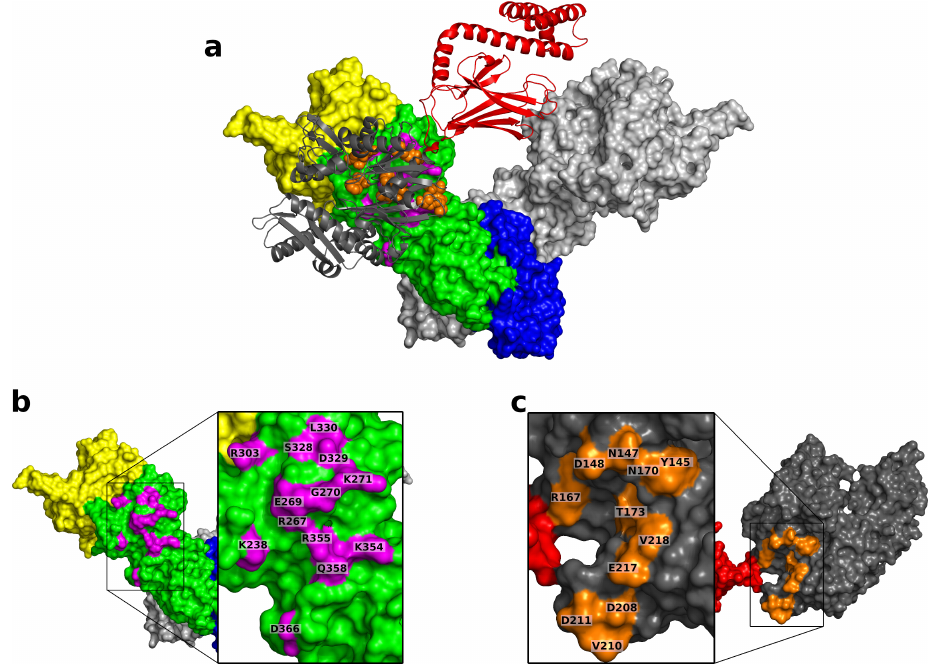
Figure 1. DnaK-Hsp90 Ec docked model. The residues of DnaK and Hsp90 Ec that are involved in the direct interaction have previously been described [65,66,72]. ( a ) Hsp90 Ec -DnaK docked model. ( b ) Residues of Hsp90 Ec (magenta) that interact with DnaK are localized in the MD (green) outside of the cleft of the Hsp90 Ec dimer. ( c ) Residues of DnaK (orange) that interact with Hsp90 Ec are located in the NBD